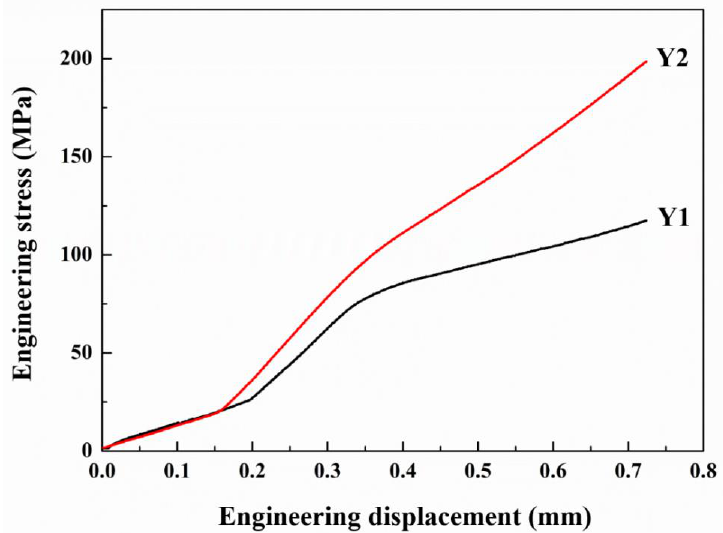
Figure 7. Engineering stress-engineering displacement curves of two samples.